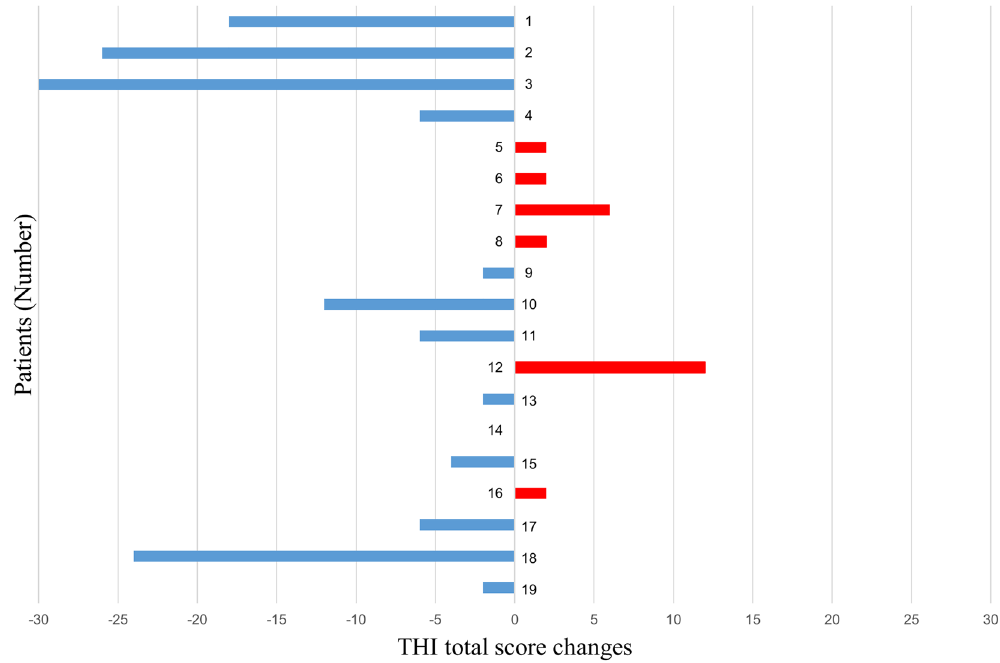
Figure 5. Changes in THI total score. 12 of 19 Patients showed improvement in THI total score (THI, Tinnitus Handicap